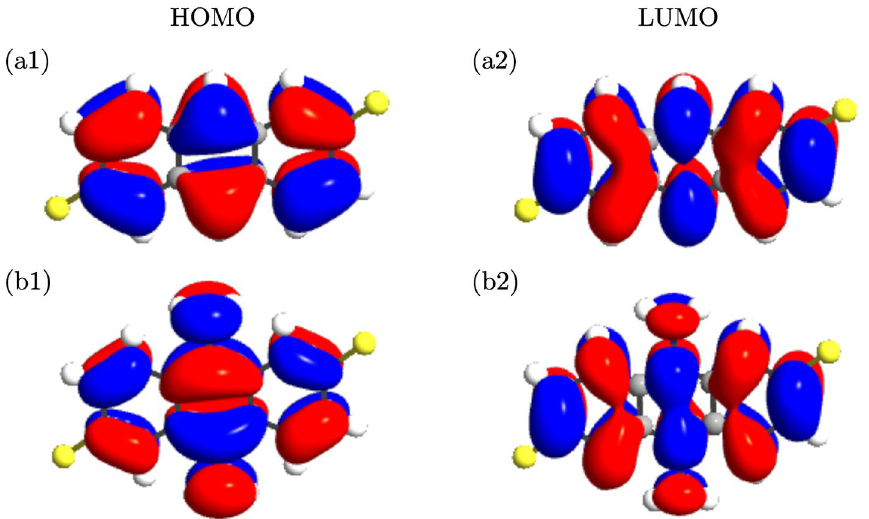
Figure 5. The calculated HOMO and LUMO orbitals of the anthracene molecule coupled to the thiol anchoring group, ( a1, a2 ) in the absence of side groups, and ( b1, b2 ) when the amine side group is attached to the molecule in the R ′ position. The isovalue of each molecular orbital surface was 0.05